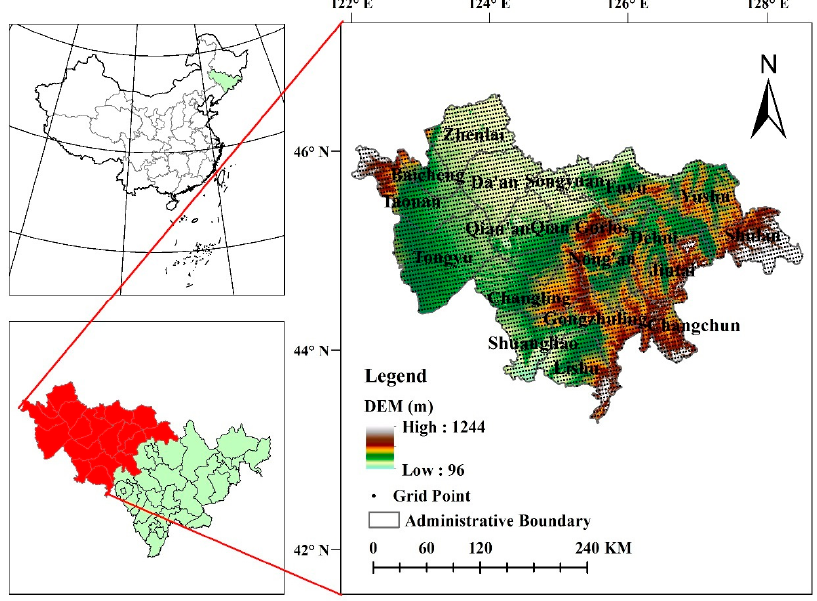
Figure 1. Location of the study area.